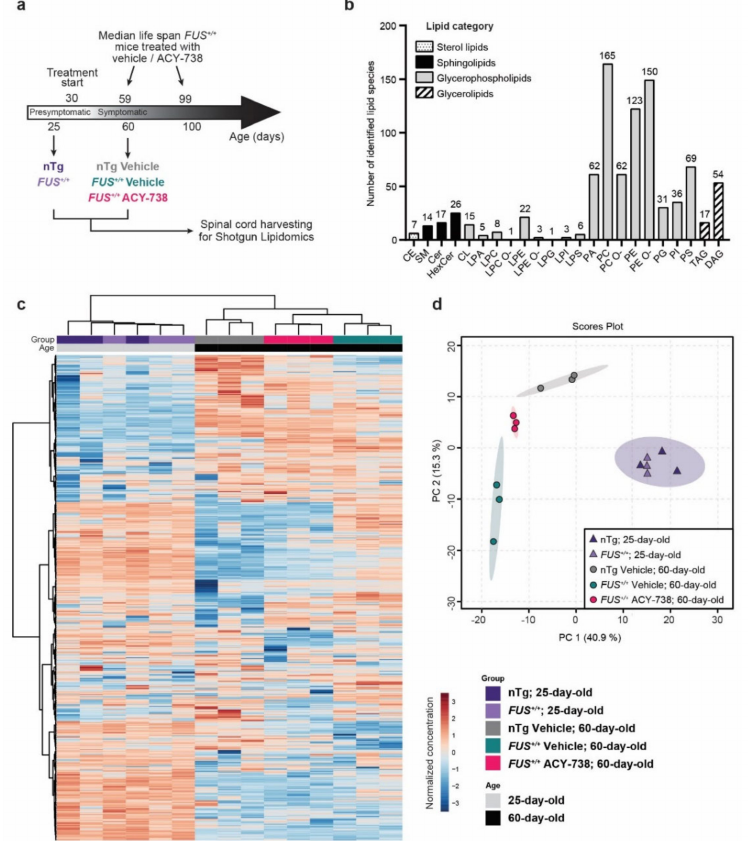
Figure 1. Whole spinal cord lipidome data show modifications of lipid homeostasis according to age, genotype, and treatment. ( a ) Schematic of the experimental design. FUS +/+ mice develop motor symptoms after 30 days of age and have a median survival of 59 days [6,21]. Treatment with ACY-738, provided in crushed food mixed with water at a dose of 100 mg/kg, extends survival to 99 days and ameliorates disease phenotype [6]. Whole spinal cords were collected for shotgun lipidomics on presymptomatic (25-day-old) nTg and FUS +/+ mice and symptomatic (60-day-old) vehicle-treated nTg and vehicle- or ACY-738-treated FUS +/+ mice. ( b ) Number of identified lipid species per lipid class. Lipids classes are regrouped into four main categories. Abbreviations of the lipid classes are defined in the Supplementary Information File. ( c ) Heatmap representing all samples and color-coded normalized concentrations of all individual lipid species. The colors vary from deep blue to reddish-brown to indicate values below and above the mean normalized concentrations for a given lipid species, respectively. Cluster analysis was performed to display samples in columns and lipid species in rows. ( d ) Principal component analysis (PCA) scores plot of the whole lipidome data (15 samples; 538 lipid